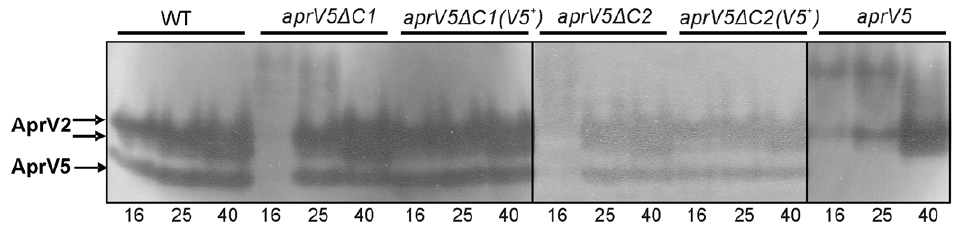
Figure 4. Extracellular protease zymograms of the aprV5 C-terminal deletion strains. Cultures from 16 h, 25 h and 40 h TAS broth cultures of the wild-type strain VCS1703A (WT), the aprV5 D 478–595 strain JIR3947 ( aprV5 D C1 ) and its complemented derivative JIR3968 ( aprV5 D C1 ( V5 + )), the aprV5 D 503–595 strain JIR3956 ( aprV5 D C2 ) and its complemented derivative JIR3965 ( aprV5 D C2 ( V5 + )) and the aprV5 mutant JIR3756 ( aprV5 ) were examined. The profile of the aprV5 D 560–595 strain JIR3969 ( aprV5 D C3 ) is not shown but was identical to that of aprV5 D C2 .